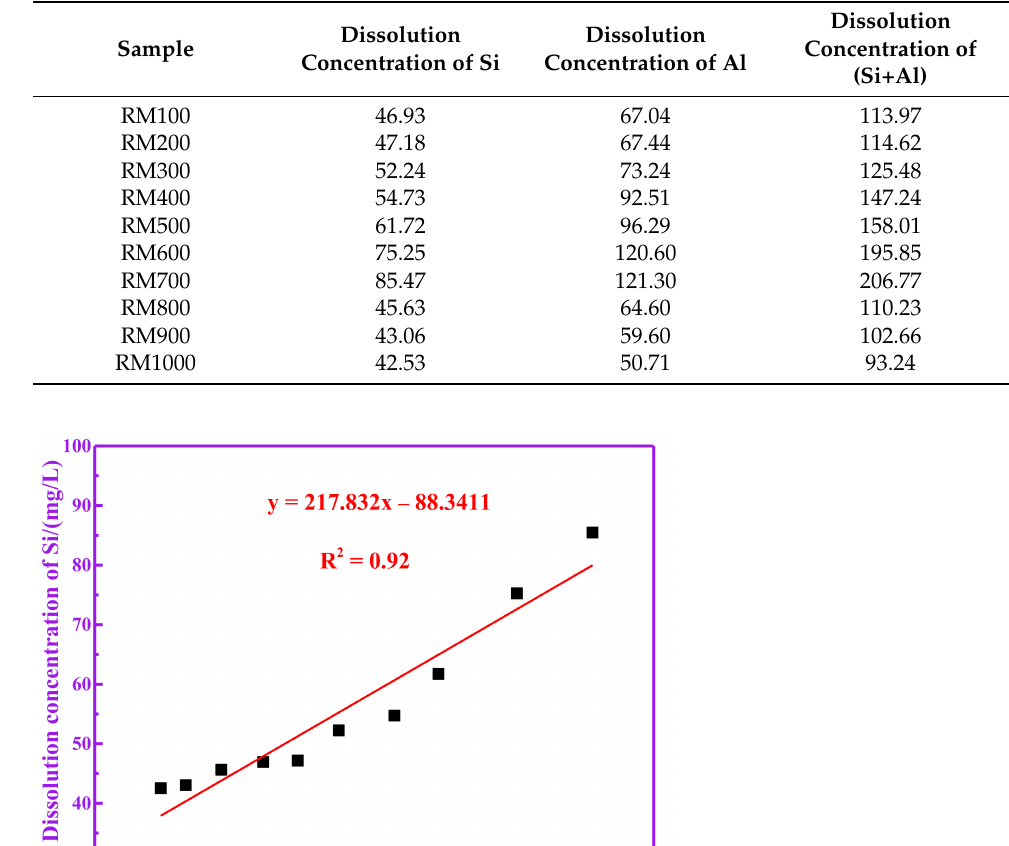
Table 3. The dissolution concentration of Si and Al in calcined RM at different temperatures (mg/L).